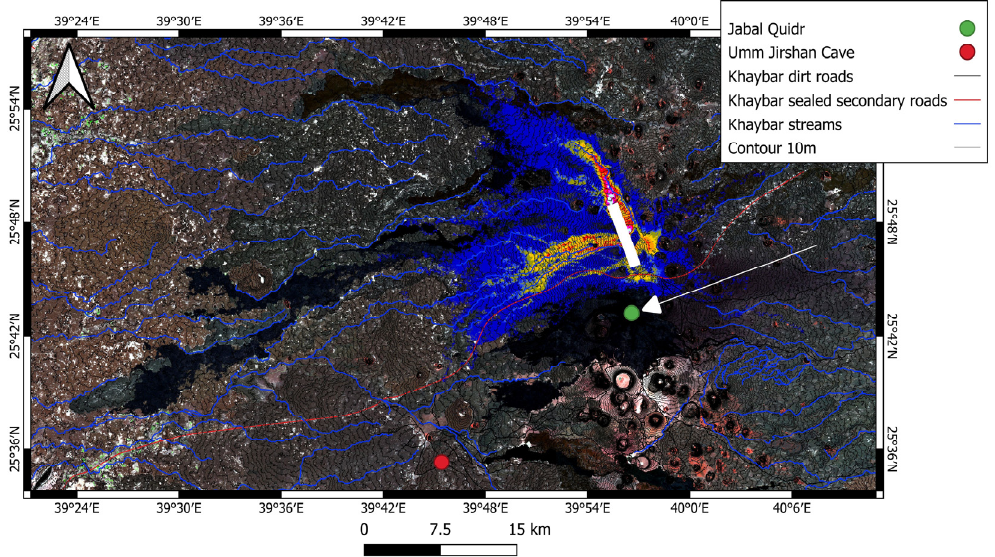
Figure 20. JQ fissure simulation with the same lava thickness parameters and 500 km simulation distances yielded a good match with the lava flow distribution pattern observed but failed to let the lava flow inundate the distant areas. Lava flow inundation reached only those zones observed in the field that acted as ponded regions. The green dot marks Jabal Quidr, while the red dot is the location of the Umm Jirsan lava tube.